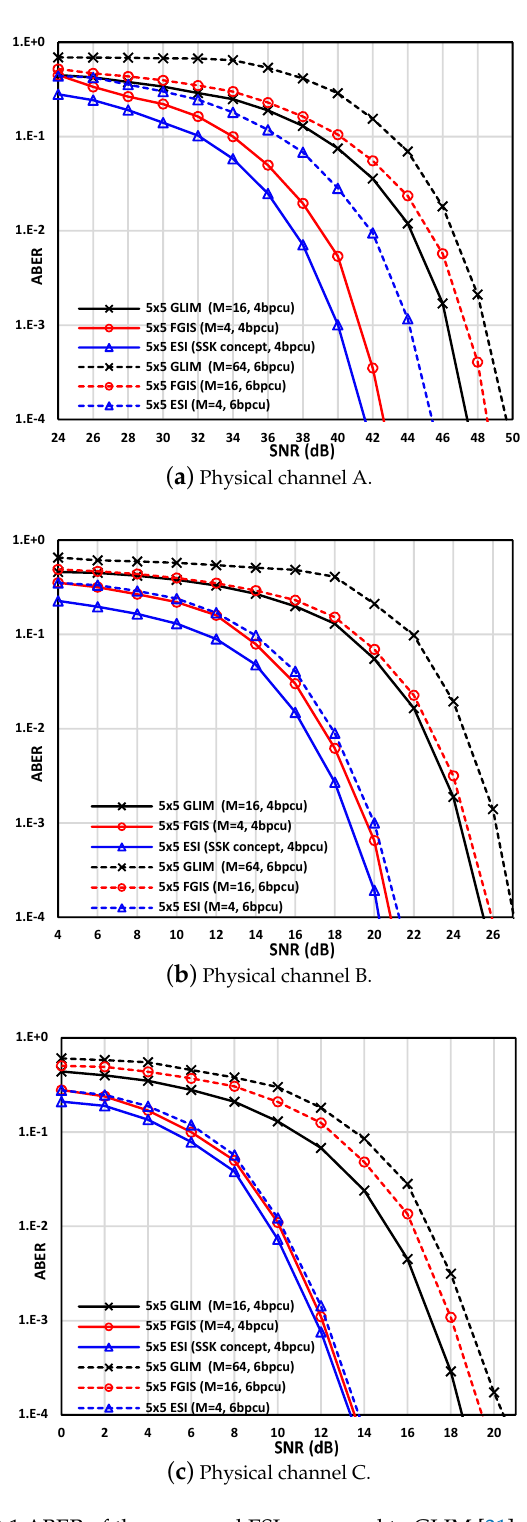
Figure 5. Scenario 2 test 1 ABER of the proposed ESI compared to GLIM [31] and FGIS [33] at the same MIMO-LED configurations, but with different modulation orders (M) to achieve the same SE for three physical channels A, B and